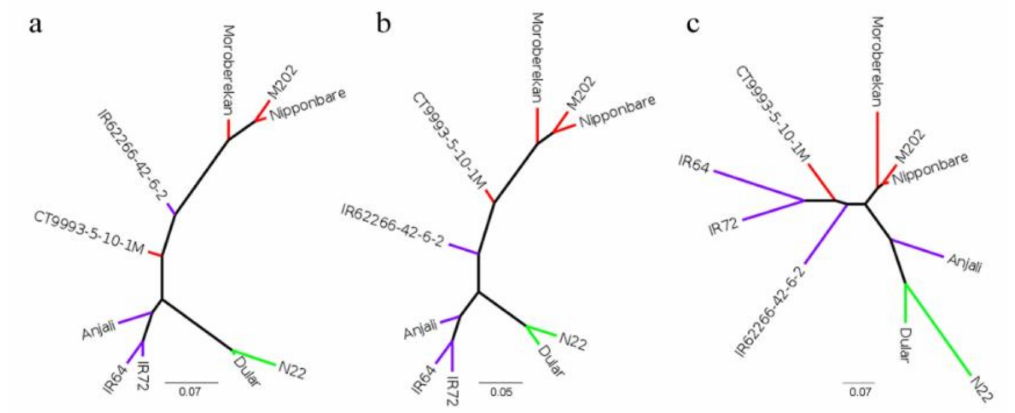
Figure3. PhylogenetictreesconstructedwithSNPhylo. TreesarebasedonSNPsfromthetranscriptomes of ten Oryza sativa L. ( Poaceae ) cultivars from the subspecies aus , indica and japonica after collapsing redundant transcripts with cogent ( a ), cDNA cupcake ( b ) and TAMA ( c ). Red— japonica , purple— indica , green— aus